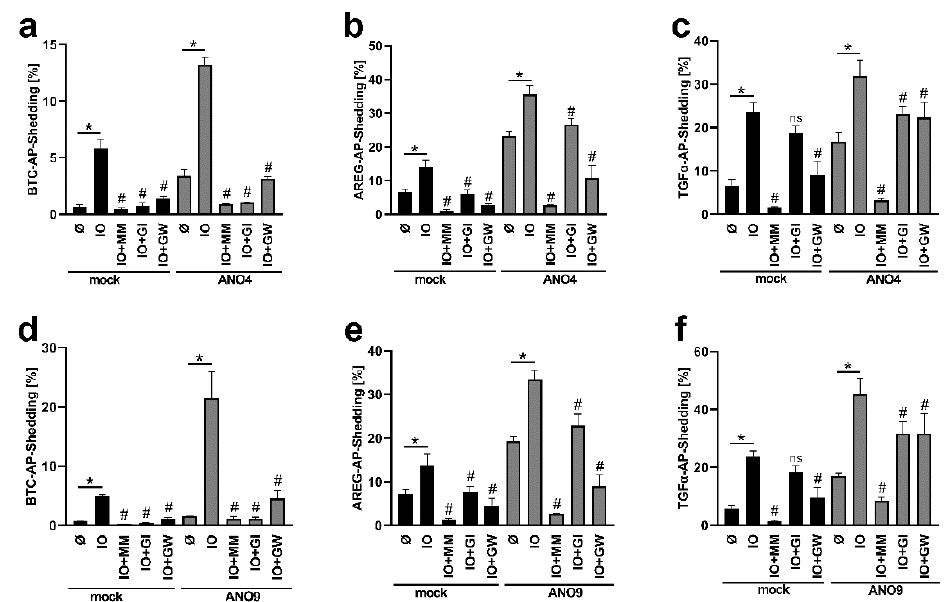
Figure 3. Ionomycin-induced shedding of BTC and AREG in ANO4- and ANO9-overexpressing HEK cells is ADAM10/17-dependent. HEK293T cells were co-transfected with ANO4 ( a – c ) or ANO9 ( d – f ) (grey columns) or mock vector (black columns) and the AP-tagged ADAM10/17 substrates ( a , d ) BTC, ( b , e ) AREG, or ( c , f ) TGF α . Cells were stimulated with IO (1 µM) for 30 min in the absence or presence of ADAM10 inhibitor GI (3 µM), ADAM10/17 inhibitor GW (3 µM) or broad-spectrum metalloprotease inhibitor marimastat (MM, 10 µM) and analyzed for the release of soluble BTC, AREG or TGF α . * indicates a significant increase compared to unstimulated cells, # indicates a significant decrease compared to corresponding stimulated cells, and ns indicates no significant difference (n = 3; * p < 0.05; ± SEM). Data were analyzed by one-way ANOVA and Holm–Sidak multiple comparison post hoc test.